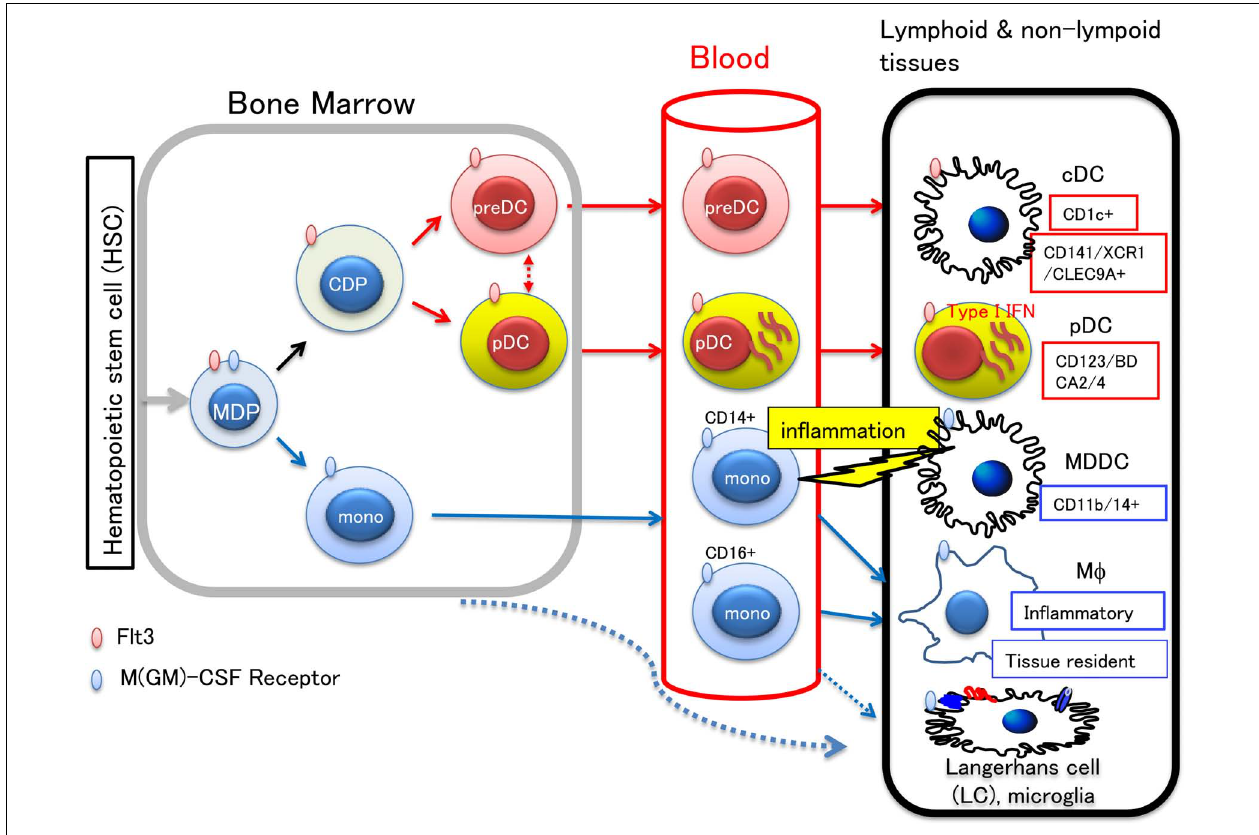
FIGURE 1 | Development of myeloid cells and lineage relationship between DC subsets. Hematopoietic stem cells in the bone marrow differentiate into monocyte/macrophage and DC precursor (MDP), which commits to a distinct lineage cell, either becoming a monocyte or common DC precursor (CDP). CDP differentiates to preDC or pDC, and migrates to the peripheral tissues through blood. In the lymphoid or non-lymphoid tissues, preDC can become either of two types of cDC: CD1c + DC and CD141 + /XCR1 + /CLEC9A + DC, the latter of which has high cross-presenting activity. In the blood, CD14 + or CD16 +